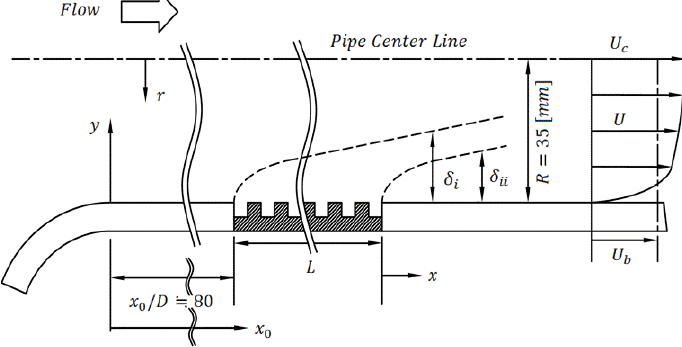
Fig.1 Nomenclature and coordinate system of pipe